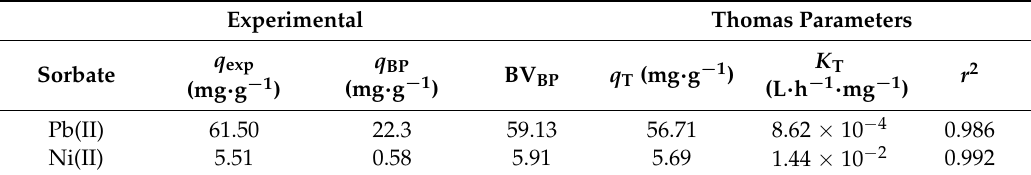
Table 6. Sorption parameters for continuous system using CAM-D2EHPA material as sorbent.